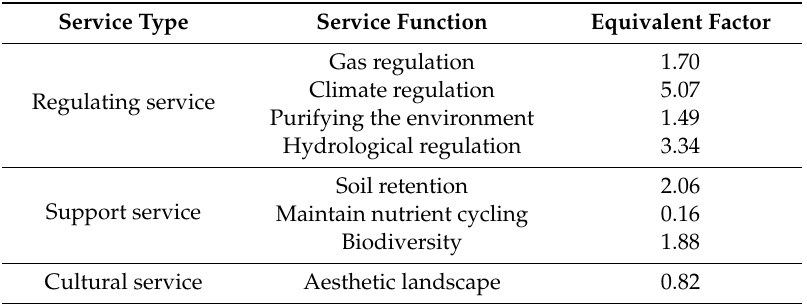
Table 3. Equivalent service value of forest ecosystem per unit area of coniferous